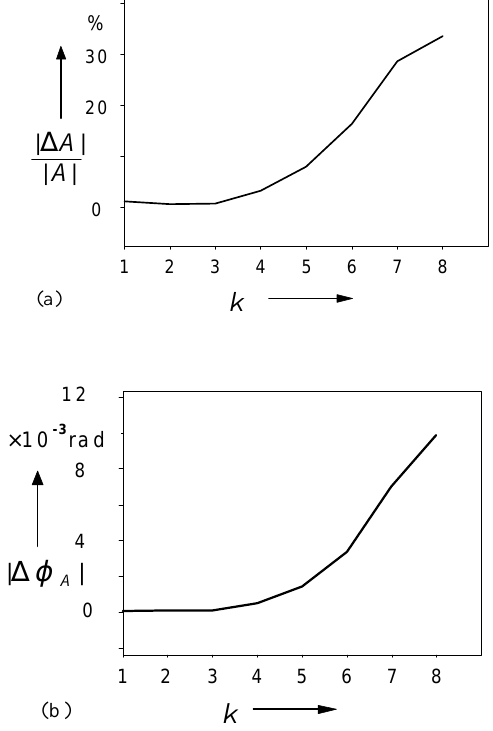
Fig. 10. (a) Relative amplitude error | ∆ A | / | A | and (b) phase er- ror | ∆ ϕ A | of the acceleration spectrum obtained for non-ideally generated quadrature signals with | q | = 0 . 1 . Impulse parameters: a G,m = 10 3 m/s 2 , T G = 50 µ